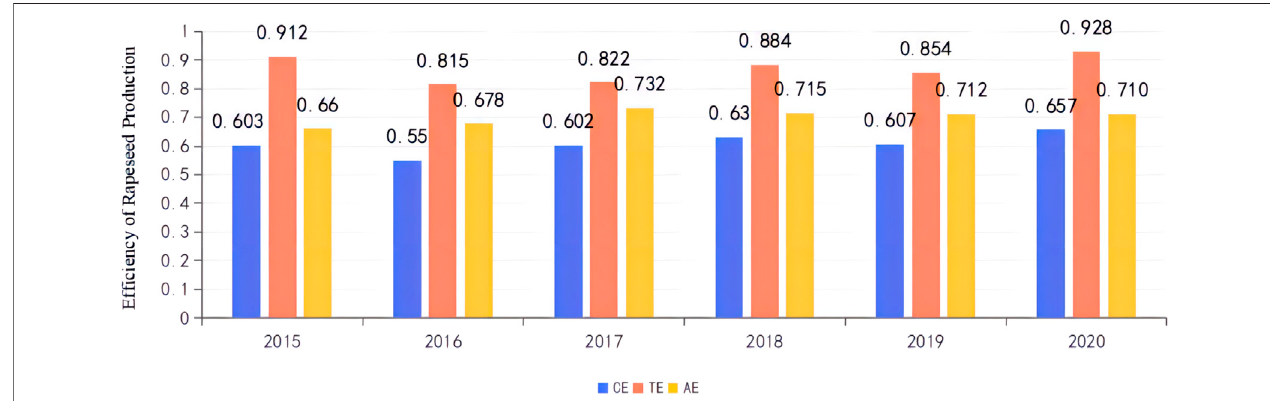
FIGURE 3 | Cost ef fi ciency of rapeseed production in different periods.